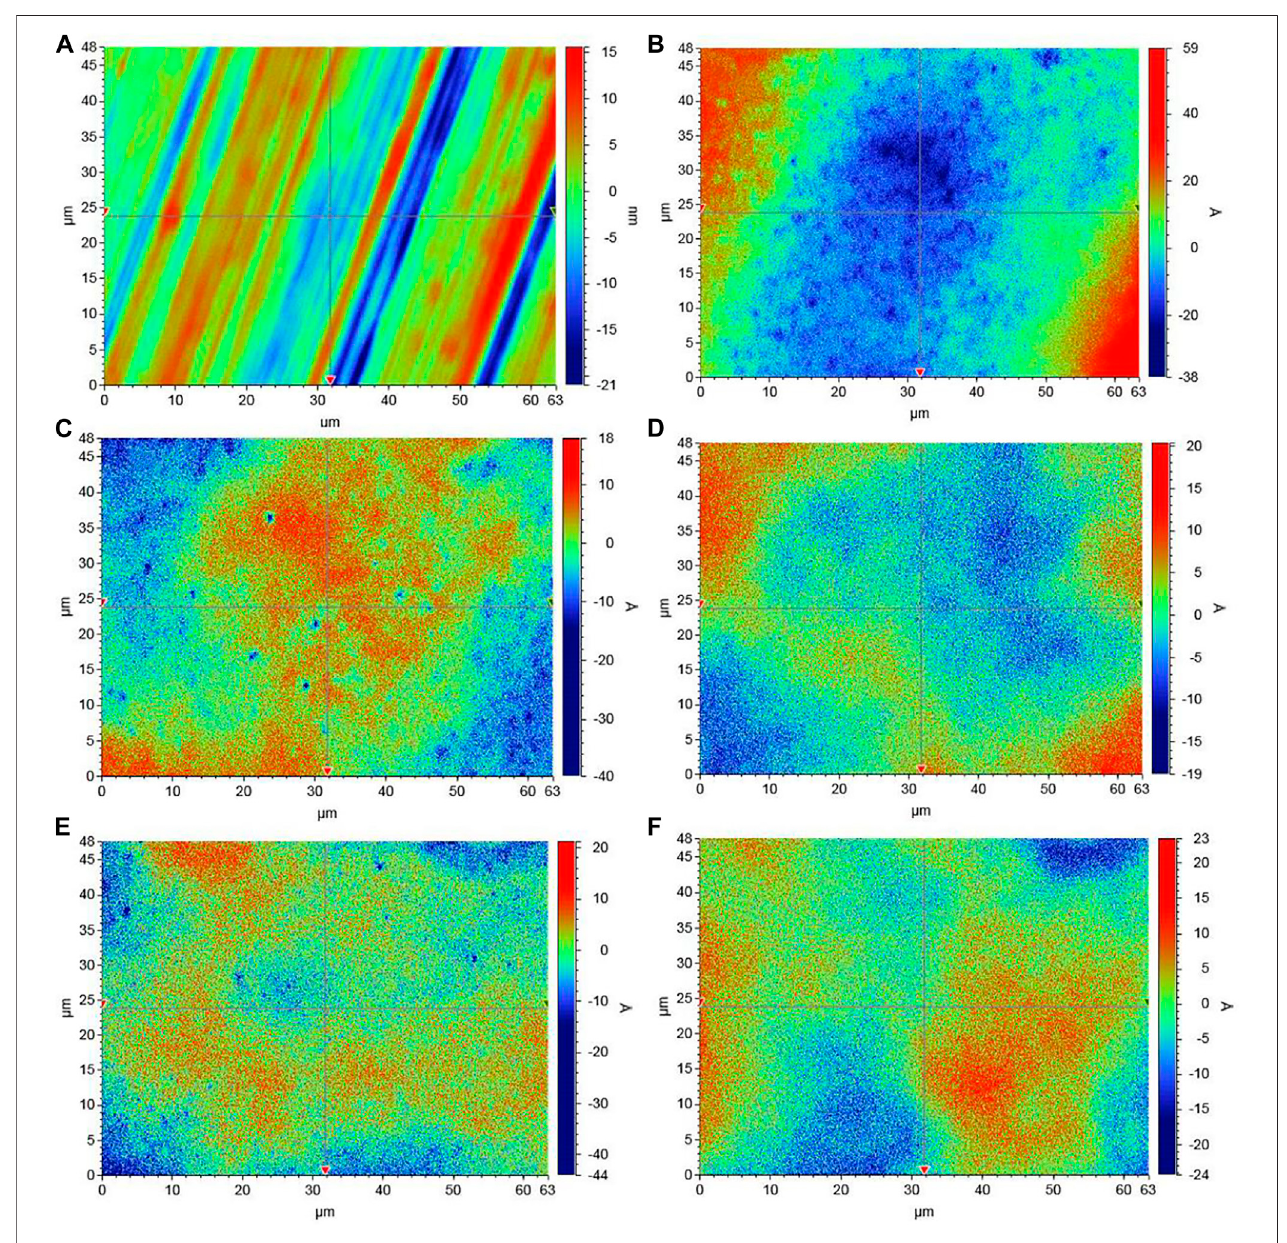
FIGURE 7 | WLI images of GaSb surface with polishing times of. (A) 0, (B) 20, (C) 50, (D) 90, (E) 120 and (F) 150 min.